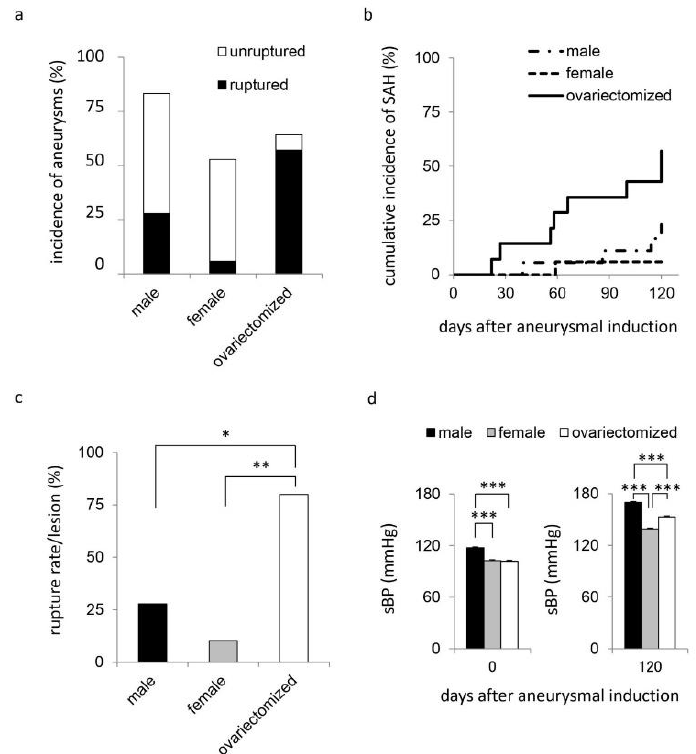
Figure 1. The incidence of intracranial aneurysms, the cumulative incidence of subarachnoid hemorrhage and the rate of rupture of induced lesions. To induce intracranial aneurysms, 10-week-old male ( n = 18) or female Sprague − Dawley rats ( n = 31) were subjected to the ligation of the left carotid artery, the right external carotid artery and the right pterygopalatine artery, and systemic hypertension by the combination of a high salt diet and the ligation of the left renal artery. In some female rats ( n = 14), the bilateral ovariectomy was also applied. Animals were maintained for 120 days after surgical manipulations. The incidence of intracranial aneurysms ( a ), the cumulative incidence of subarachnoid hemorrhage (SAH) ( b ), the rate of rupture of induced lesions ( c ) or systolic blood pressure (sBP) ( d ) in each group; male rats, female rats without ovariectomy (female) or female rats with the bilateral ovariectomy (ovariectomized), are shown. Bars in ( d ) indicate the mean ± SEM. Statistical analysis was done by the Tukey-Kramer method in ( c , d ). * p < 0.05, ** p < 0.01, *** p < 0.001.